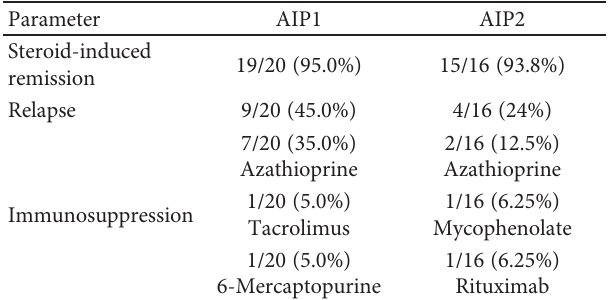
Table 3: Incidence of malignancy in our cohort [CCC, cholangiocellular carcinoma; HCC, hepatocellular